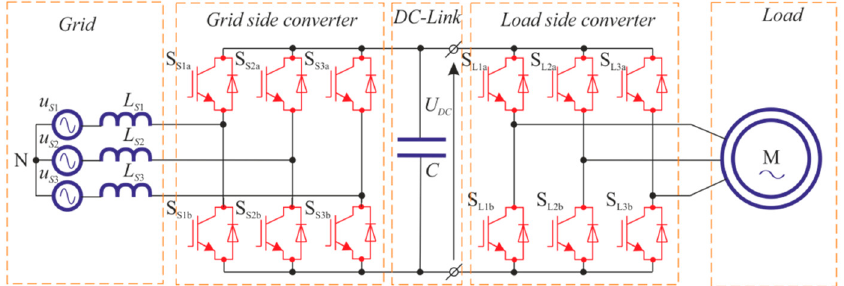
Figure 1. Two-level back-to-back converter with DC-link.